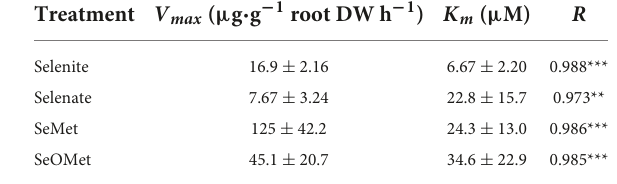
TABLE 1 Kinetic parameters for the influx of four forms of Se into rice